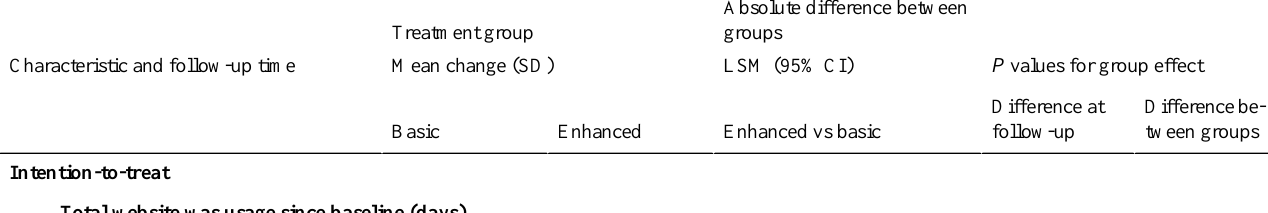
follow-upEnhanced vs